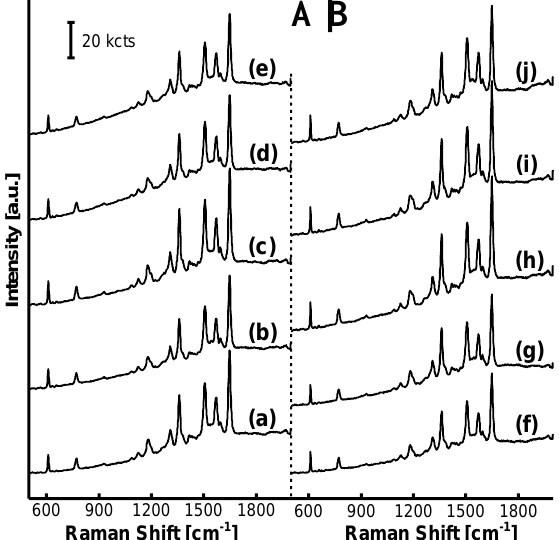
Figure 5. SERRS spectra of AgNP/MF 6 vs. treatment time and acid-volume in the MF 6 acid-treatment reaction: ( a ) 10, ( b ) 20, ( c ) 40, ( d ) 60 and ( e ) 80 min in ( A ) were collected on the substrate incorporating the acid-treated MF 6 microspheres at varied treatment times, from 10 to 80 min; meanwhile, ( f ) 1 × , ( g ) 2 × , ( h ) 3 × , ( i ) 4 × and ( j ) 5 × times in ( B ) were collected on the substrate incorporating the acid-treated MF 6 microspheres at varied acetic acid volumes, from 1 × to 5 × times 90 mL. The SERRS performance of the substrate was nearly stable.